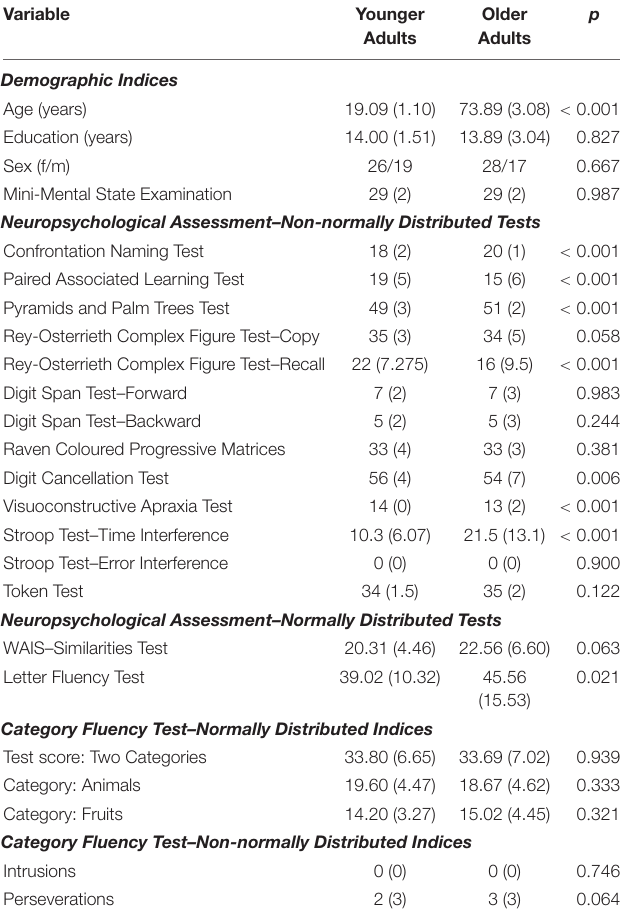
TABLE 1 | Demographic and neuropsychological description of the